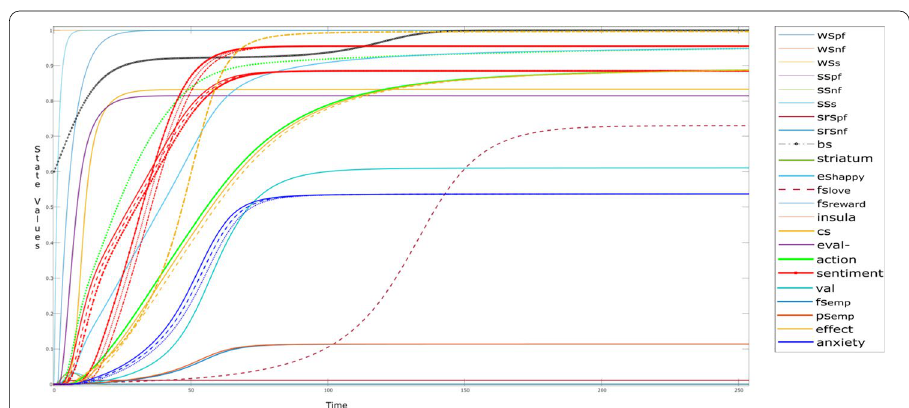
0 and ws nf 1: reaction is negative = =